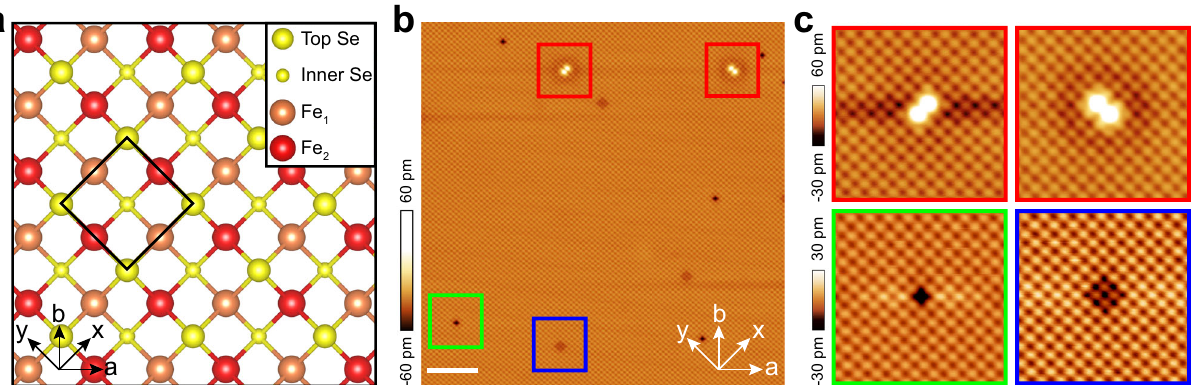
Fig. 1 Crystal structure and surface characterization of FeSe. a Top view of the schematic structure of FeSe. The a and b axes are de fi ned by the Fe lattice. The x and y axes are de fi ned by the Se lattice. The black diamond indicates the top layer Se lattice. Two different Fe sites are de fi ned by their different bonding directions with the top layer Se atoms. b Atomic-resolved topographic image (35 nm × 35 nm) taken under V b = 100 mV and I s = 20 pA (scale bar: 5 nm). c The enlargement of the red, green, and blue squares (5 nm × 5 nm) in b . The tunneling condition is V b = 100 mV and I s = 20 pA.